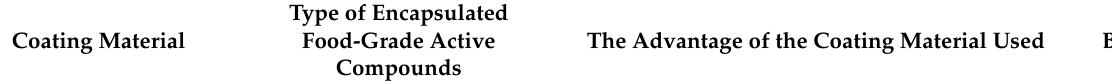
Table 4. Coating materials for liposomes with applications in the food